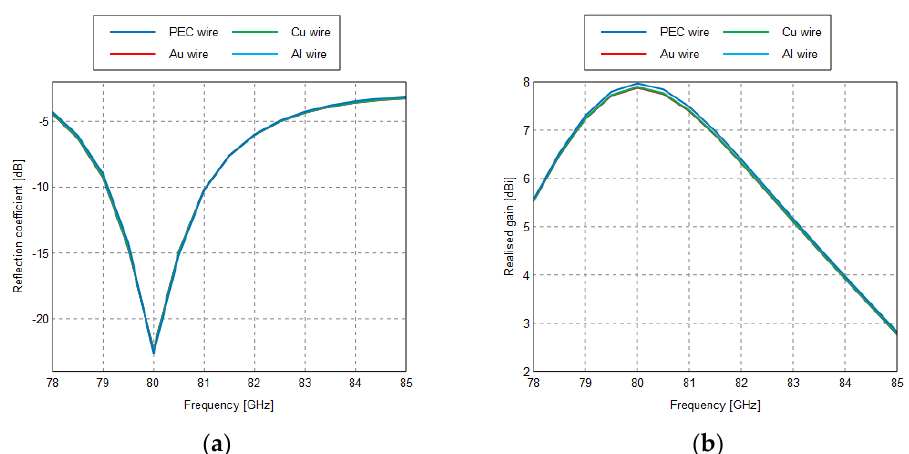
Figure 6. Simulations of the experimental design for various wire materials: perfect electric conduc- tor (PEC), copper, gold, and aluminum: ( a ) reflection coefficient; ( b ) realized gain (reflection loss included), broadside direction.